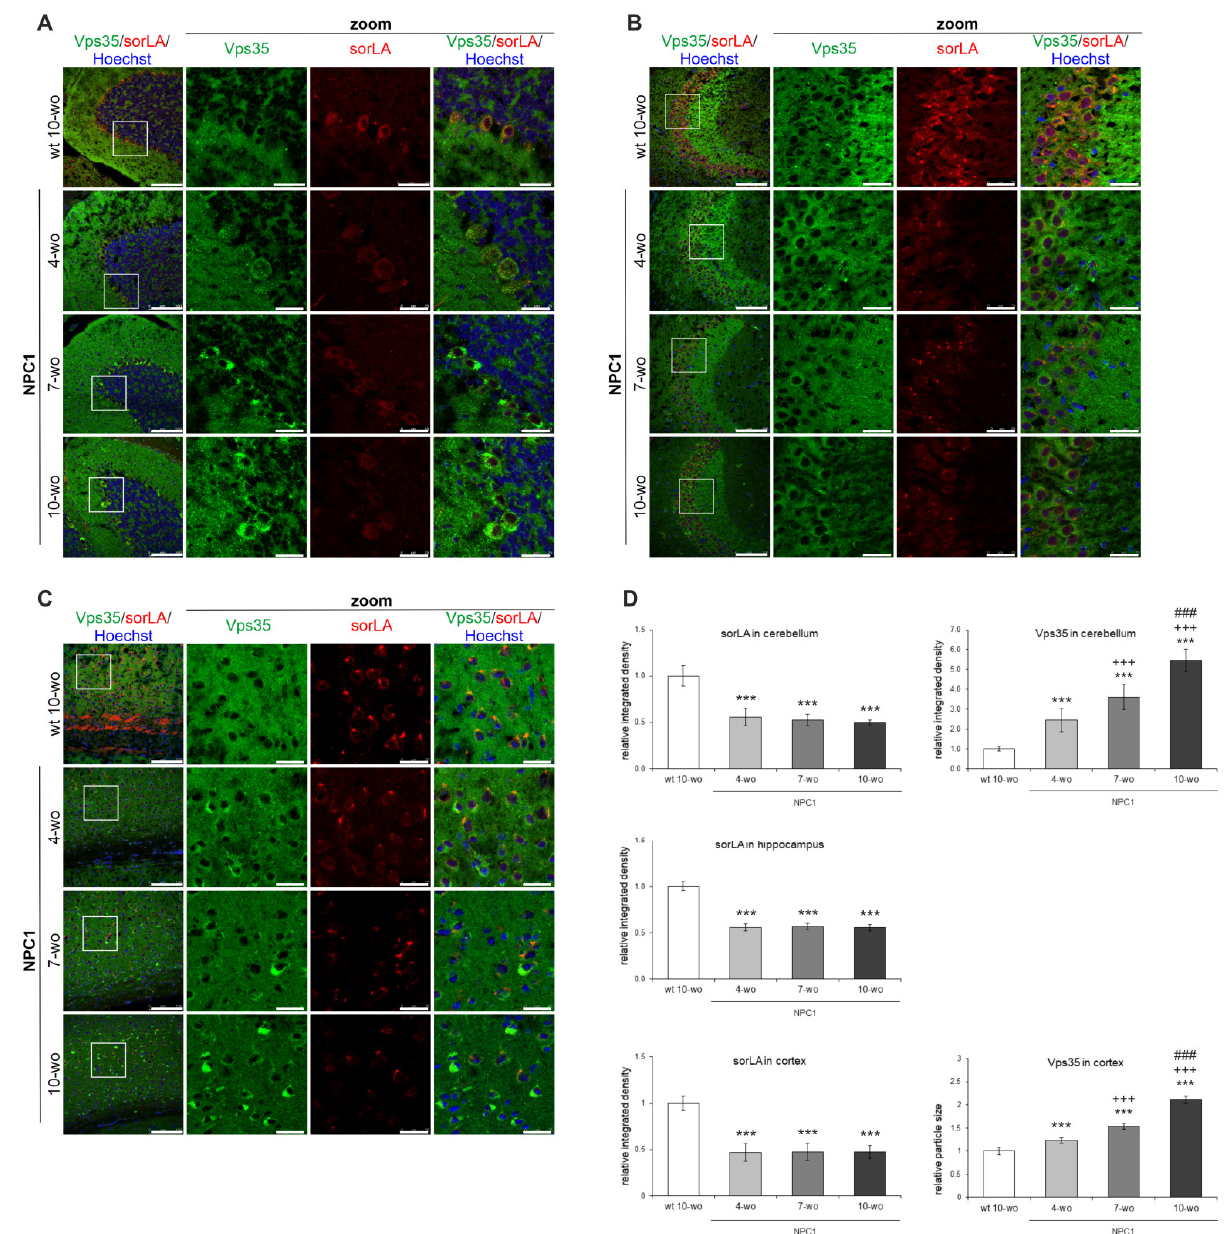
Figure 4. Altered distribution of Vps35 and sorLA in NPC1 mouse brains is already observed at the presymptomatic stage of the disease. Shown are the results of Vps35 and sorLA immunostaining of 4, 7 and 10-week old NPC1 vs. wt mouse cerebella ( A ), hippocampi ( B ) and cortices ( C ). ( D ) The obtained immunofluorescent signals in ( A – C ) were quantified using the ImageJ software. The *** ( p < 0.001) represents statistically significant signal intensities in comparison to wt brains; +++ ( p < 0.001) in comparison to NPC1 4-week old brains and ### ( p < 0.001) in comparison to NPC1 7-week old brains. The data are shown as mean ± SD normalized to control and represent data from three different experiments, n = 9 slices per animal, 6 animals per group. Scale bar—100 (unzoomed pictures) and 20 µm (zoomed pictures).